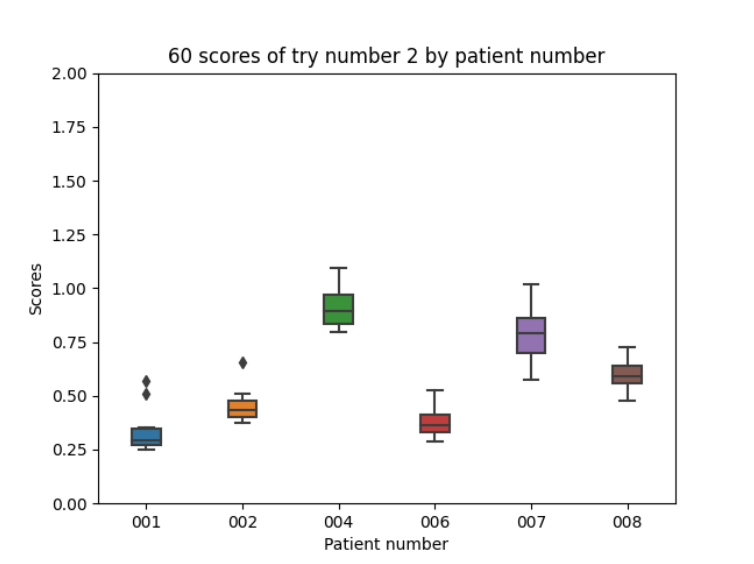
Figure 13. Experiment 2 boxplot scores, from 10 executions for each patient and configuration.